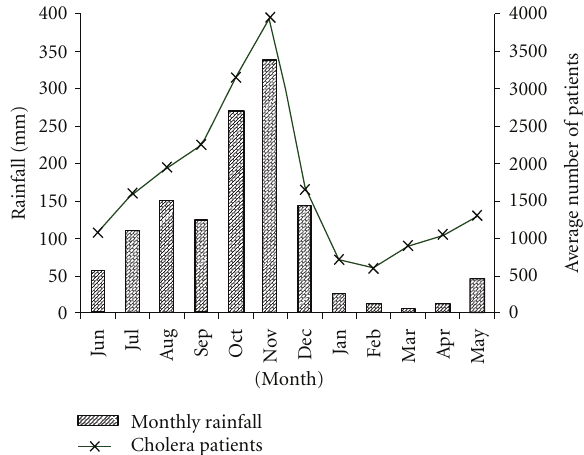
Figure 1: Historical records of seasonal rainfall and the monthly cholera diarrheal cases in Tamil Nadu, India. Bars represent rainfall and line represents monthly average of cholera